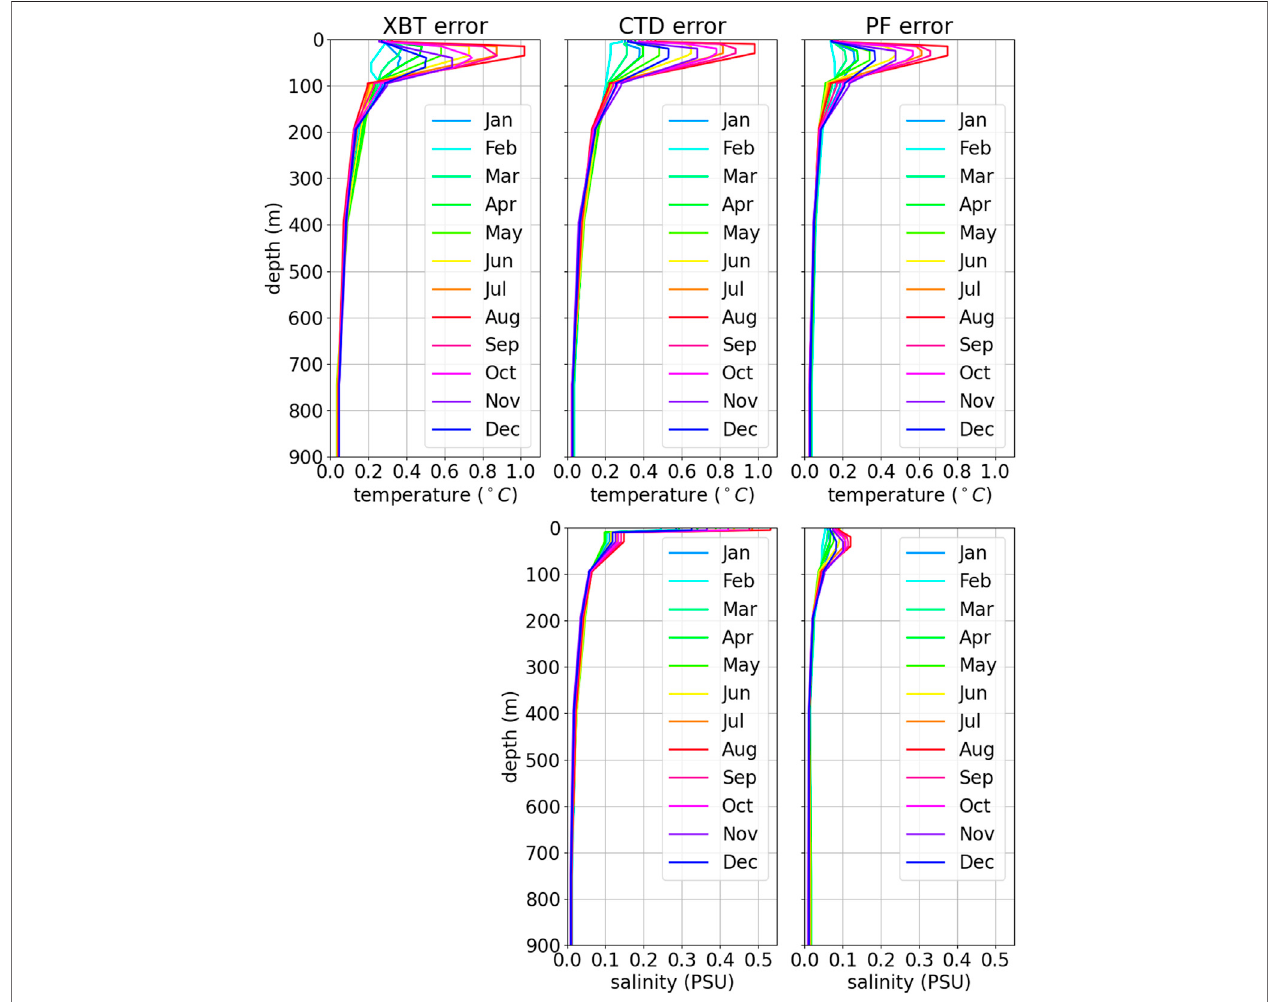
FIGURE 3 | Insitu error pro fi les used in the data assimilation. Top panels are temperature errors while bottom panels are salinity. Errors for XBT, CTD and ARGO fl oats are respectively plotted on the left, center and right columns.